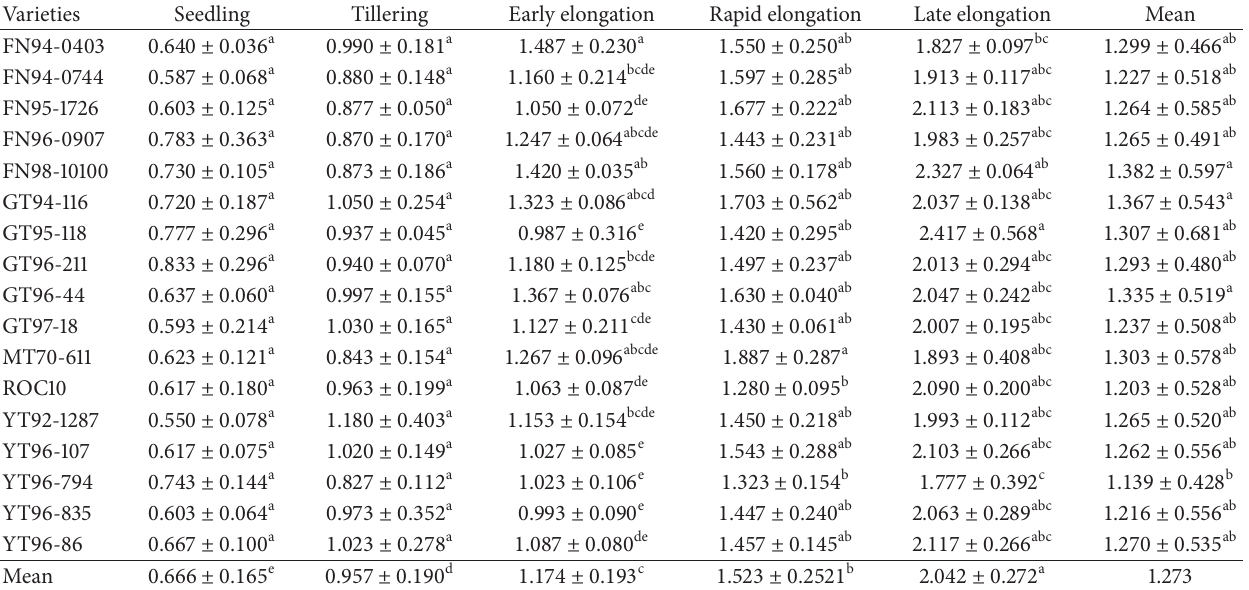
Table 1: Seasonal changes of leaf area index in sugarcane varieties.